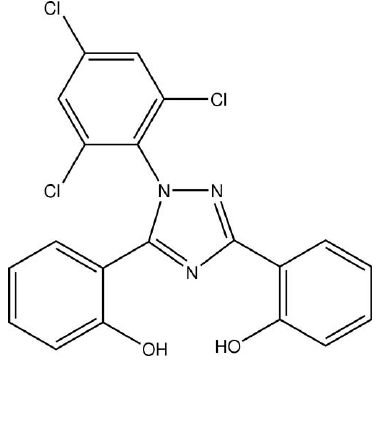
Data collection: CrystalClear (Rigaku, 2005); cell refinement: CrystalClear ; data reduction: CrystalClear ; program(s) used to solve structure: SHELXTL/PC (Sheldrick, 2008); program(s) used to refine structure: SHELXTL/PC ; molecular graphics: SHELXTL/PC ; software used to prepare material for publication: SHELXTL/PC